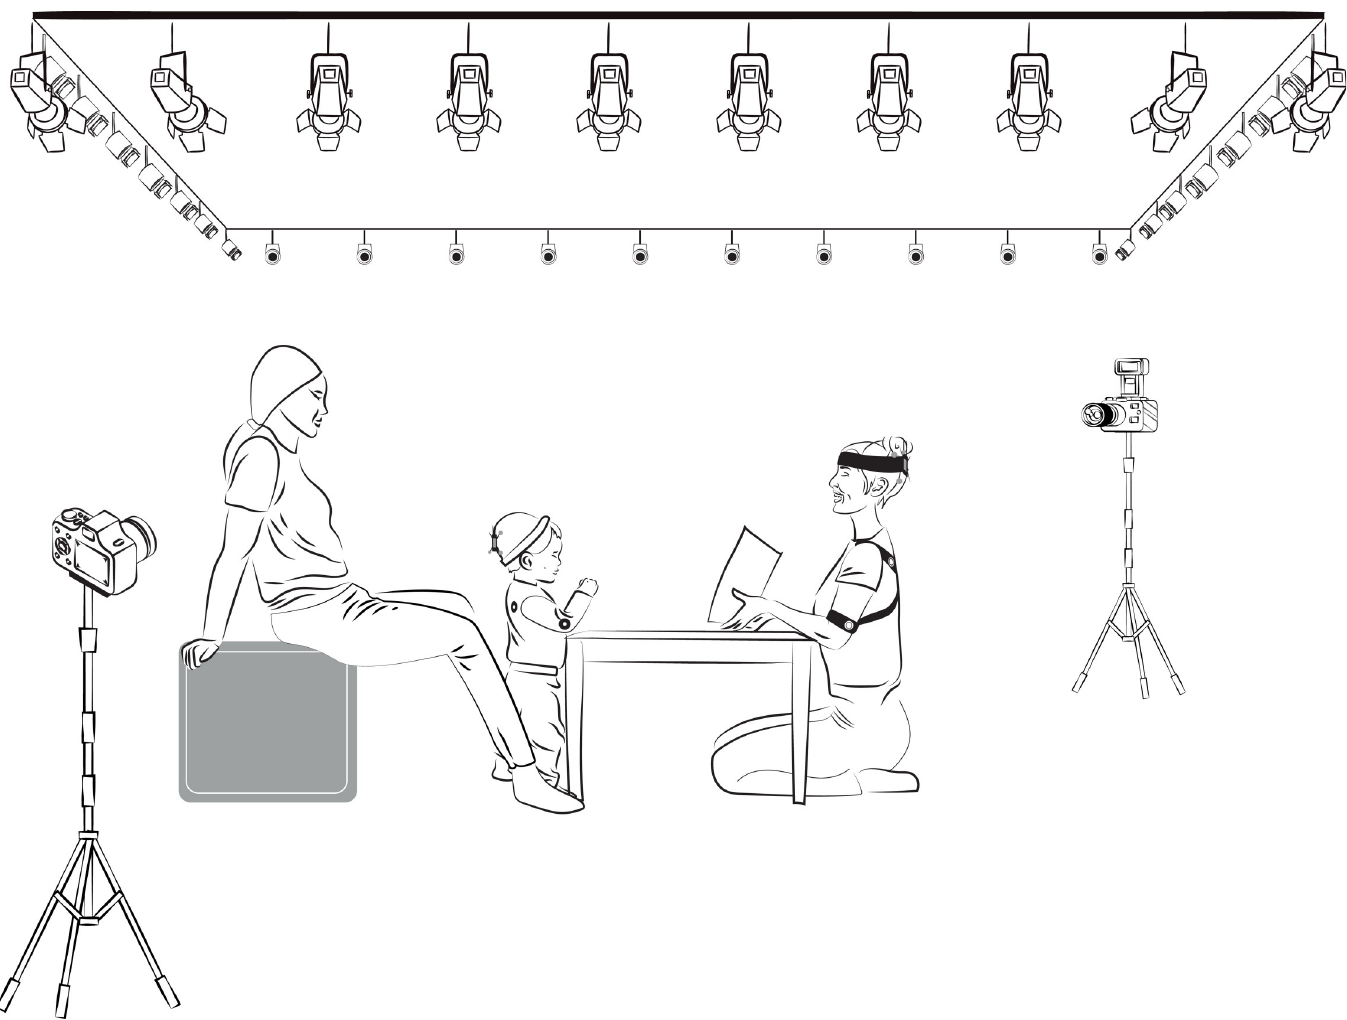
Fig 1. Illustration of the room setting and spatial disposition of the participants in spontaneous interaction context. 36 Natural Point Prime-41 purpose-specific cameras were positioned close to the ceiling, creating a rectangular perimeter above and surrounding the participants. During the reading session, the infant and the unknown adult were located in front of each other around a square table separating